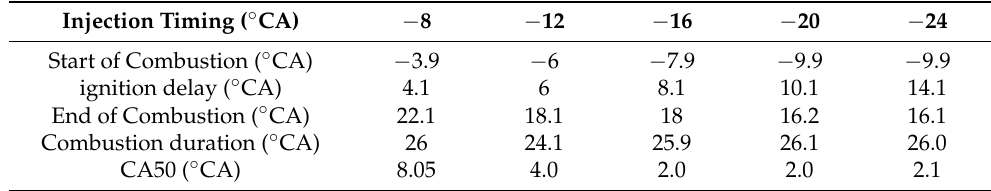
Table 5. Combustion Process Parameters with Different Injection Timing.